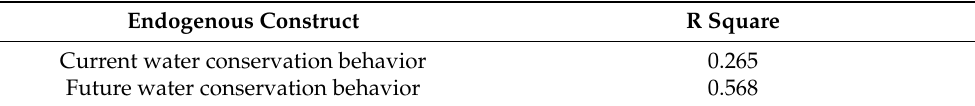
Table 4. R 2 value (coefficient of determination).